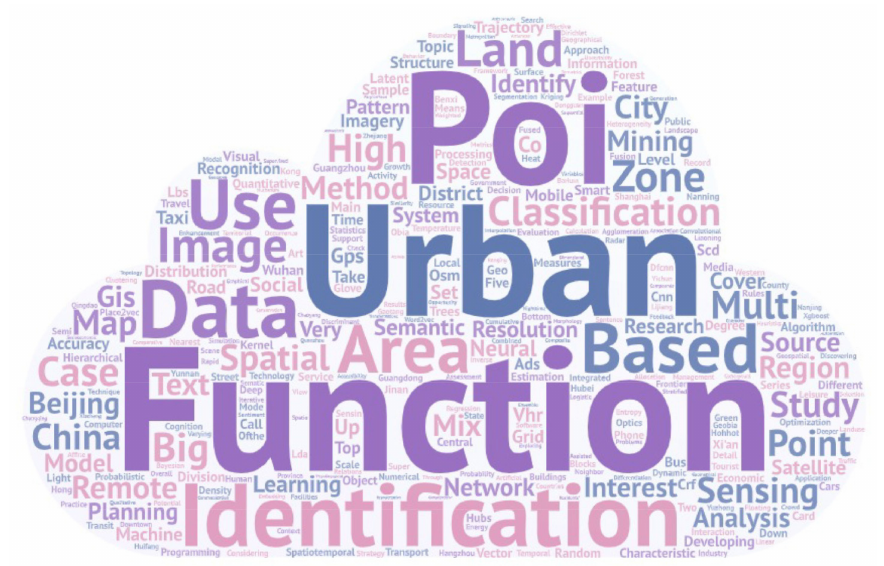
Figure 3. The word cloud of the keywords from 102